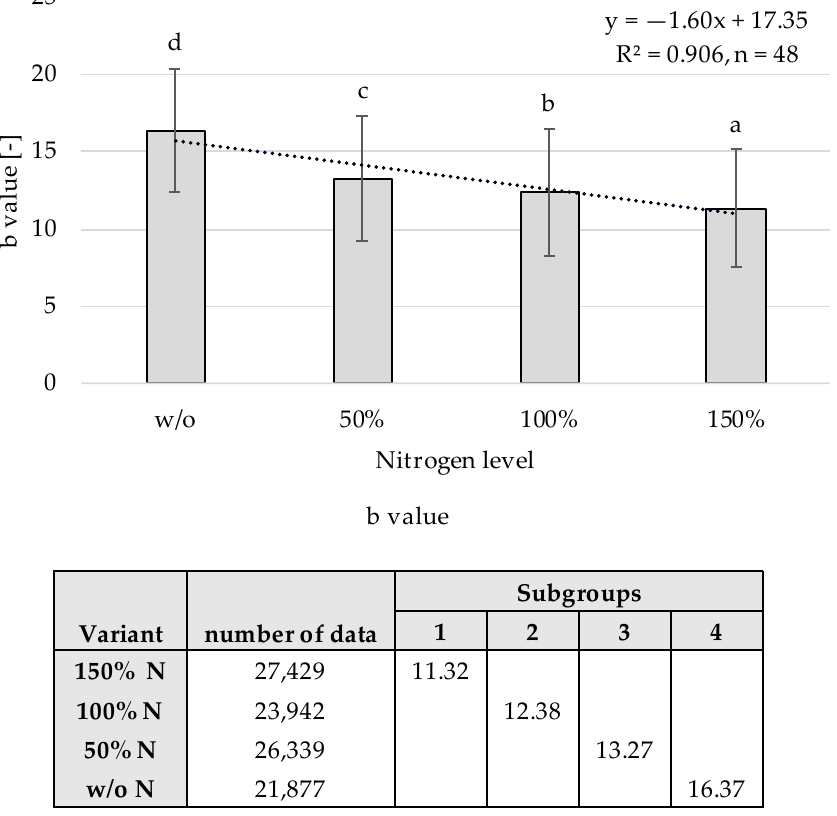
Figure 12. Statistical evaluation of the correlation between b channel and Nitrogen levels with significance levels a–d for the growth stages BBCH 32, 39, and 59 regarding a post hoc test according to Scheffé .